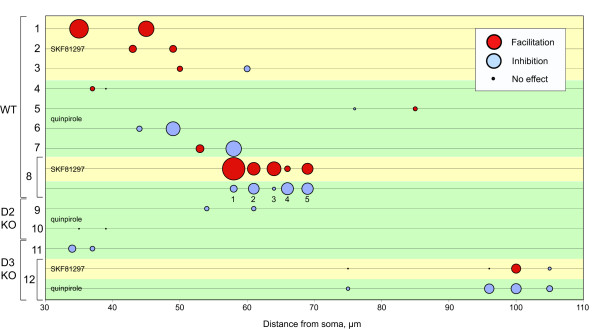
DA receptor-mediated modulation is heterogeneous. Bubble plot of spatial distribution of varicosities and magnitude of DA receptor-mediated modulation in wild type and D2 and D3 KO mice. The distance of imaged varicosities from the soma is indicated along the x-axis. Bubble area is proportional to the magnitude of modulation. Facilitation is shown in red and inhibition in purple. In experiments two experiments, both SKF81297 and quinpirole were tested sequentially in the same cell (experiments 8 and 12). In experiment 8 (data shown in Figure 3), the majority of varicosities showed both D1 receptor-mediated facilitation and D2 receptor-mediated inhibition, but the magnitude of modulation varied strikingly among individual varicosities. In experiment 12, in a D3 KO mouse, the third varicosity showed both SKF81297-mediated facilitation and quinpirole-mediated inhibition, indicating colocalization of D1 and D2 receptors.